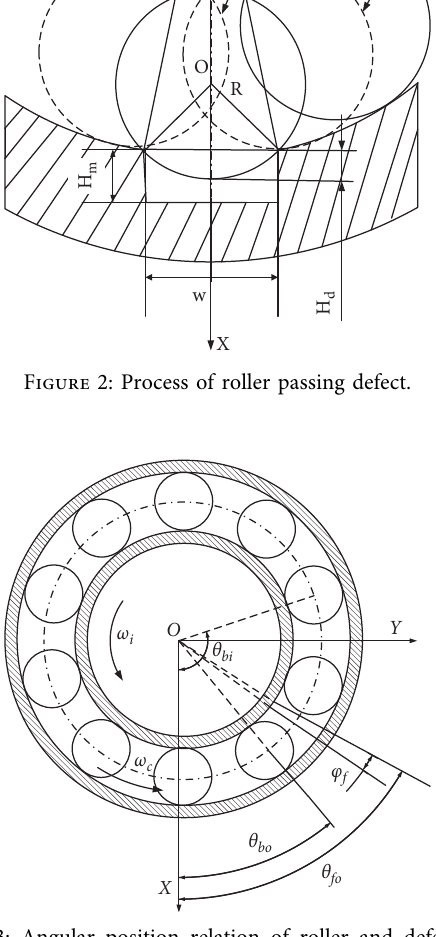
Figure 3: Angular position relation of roller and defect when bearing inner ring fault